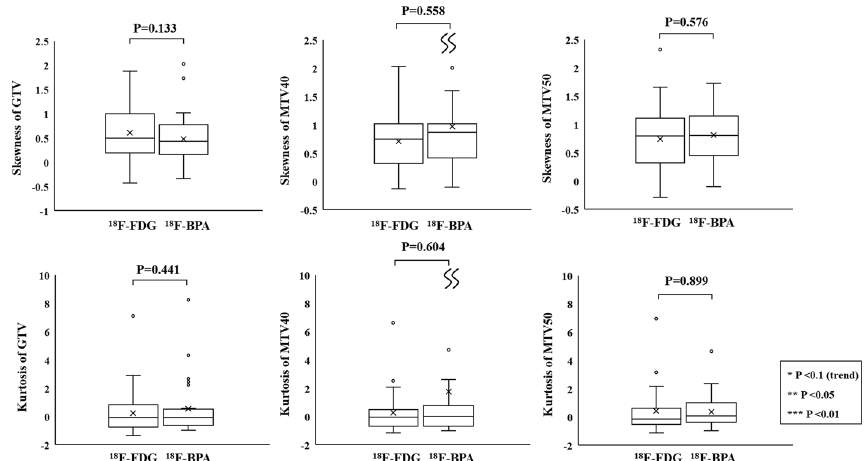
Fig. 13 The histogram indices of all patients, including skewness and kurtosis, of GTV, MTV40, and MTV50 in 18 F-FDG and 18 F-BPA